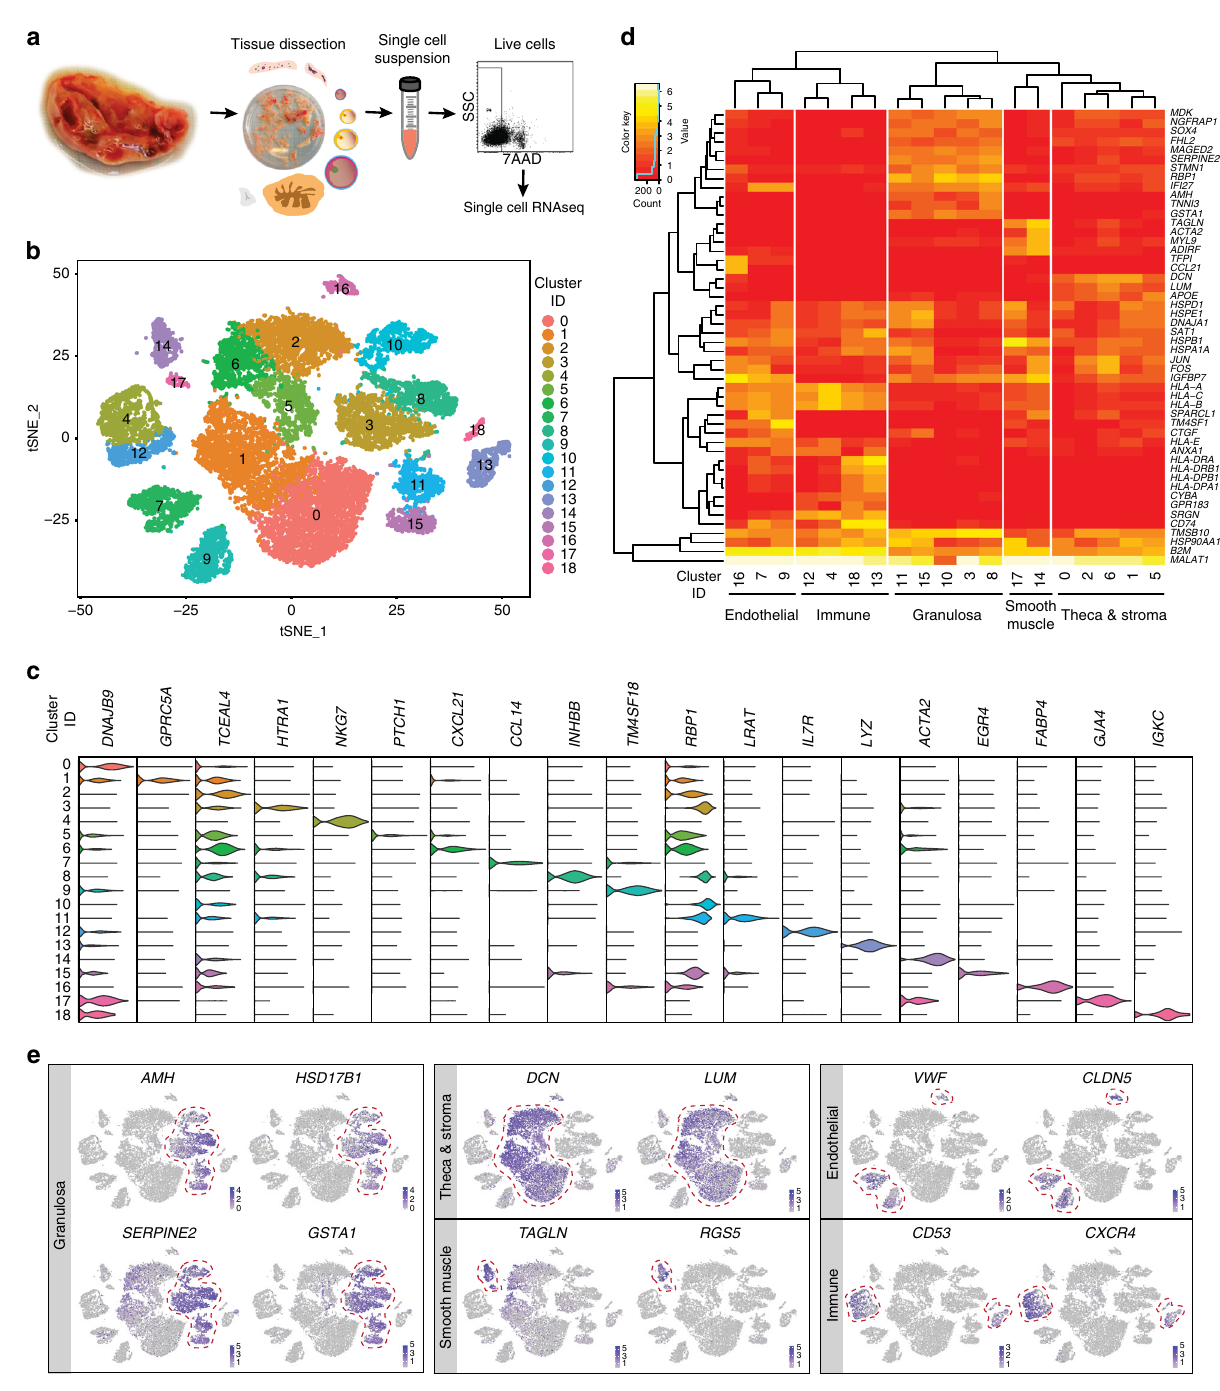
Fig. 2 Transcriptome map of human adult ovaries analyzed. a Schematic representation of human ovarian tissue preparation for single cell transcriptome analysis. b tSNE cluster map revealing 19 speci fi c clusters representing the major ovarian somatic cell types. c Violin plots showing expression of one representative differential expressed gene for each cluster. d Heatmap and hierarchical clustering based on expression of top 50 most variable genes. e tSNE cluster map showing expression of genes characteristic the major ovarian somatic cell types. Red dashed lines give the boundaries of the main clusters of interest preliminary. Pseudotime analysis using Monocle 3 alpha, that trajectories obtained by Monocle 3 alpha were consistent with the places the progenitor cell population in the middle of a longer cell trajectories obtained using Diffusion maps (Fig. 6b). trajectory segment, revealed that pGC (CL15) branched to mural Several genes not earlier associated with GC include TNNI3 , GC (CL11) and mature cumulus GC (CL8 and CL3) (Fig. 6a). As pseudotime analysis is susceptible to be affected by inter- (Fig. 6c). Due to the limited amount of samples per individual, we individual variation, we highlighted cells from two individuals cannot exclude that some genes may represent differential (P7 and P3) showing cells of both in each cluster. The cell expression between individuals. We veri fi ed the expression of NATURE COMMUNICATIONS| (2019) 10:3164